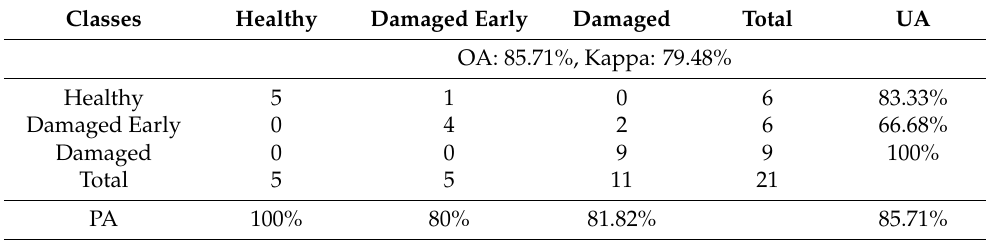
Table 4. Confusion matrix and evaluation index based on optimal mother wavelet basis (coif4) model of fresh weight moisture content.